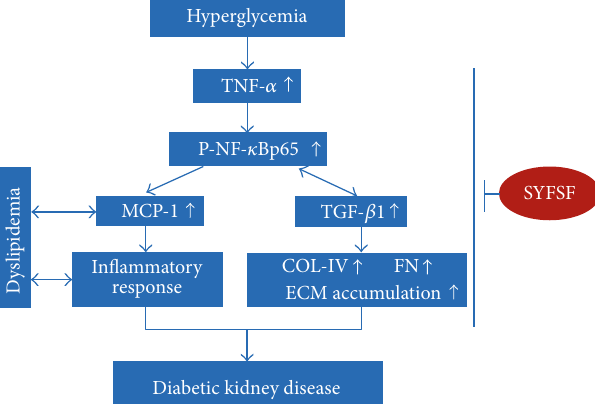
Figure 7: Schematic representation of the mechanism underlying SYFSF ’ s renoprotection which is likely associated with an inhibition of TNF- α /NF- κ Bp65-mediated signaling pathway. SYFSF probably decreases the expression of TNF- α to prevent the phosphorylation of NF- κ Bp65 induced by high glucose and then alleviates the in fl ammatory response and ECM accumulation and normalizes the